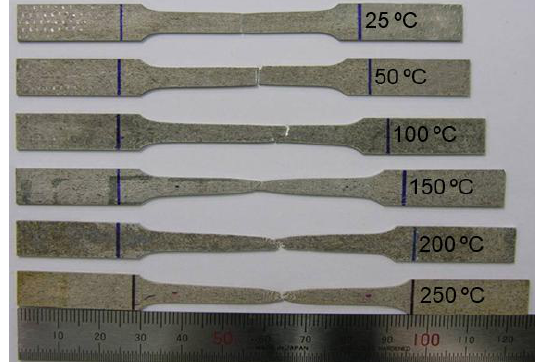
Figure 6. Specimens after uniaxial tension test at different